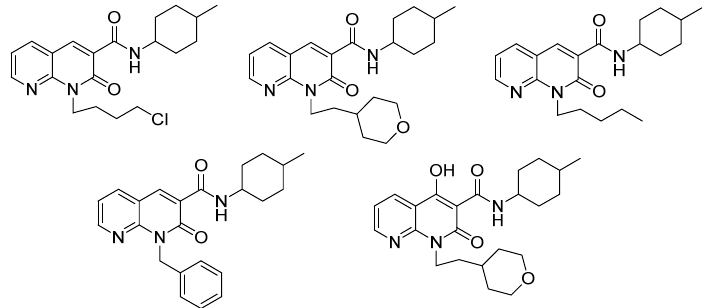
Figure 1. 1,8-naphthyridin-2(1 H )-one-3-carboxamide derivatives with antiproliferatve or/and anti- inflammatory activity.